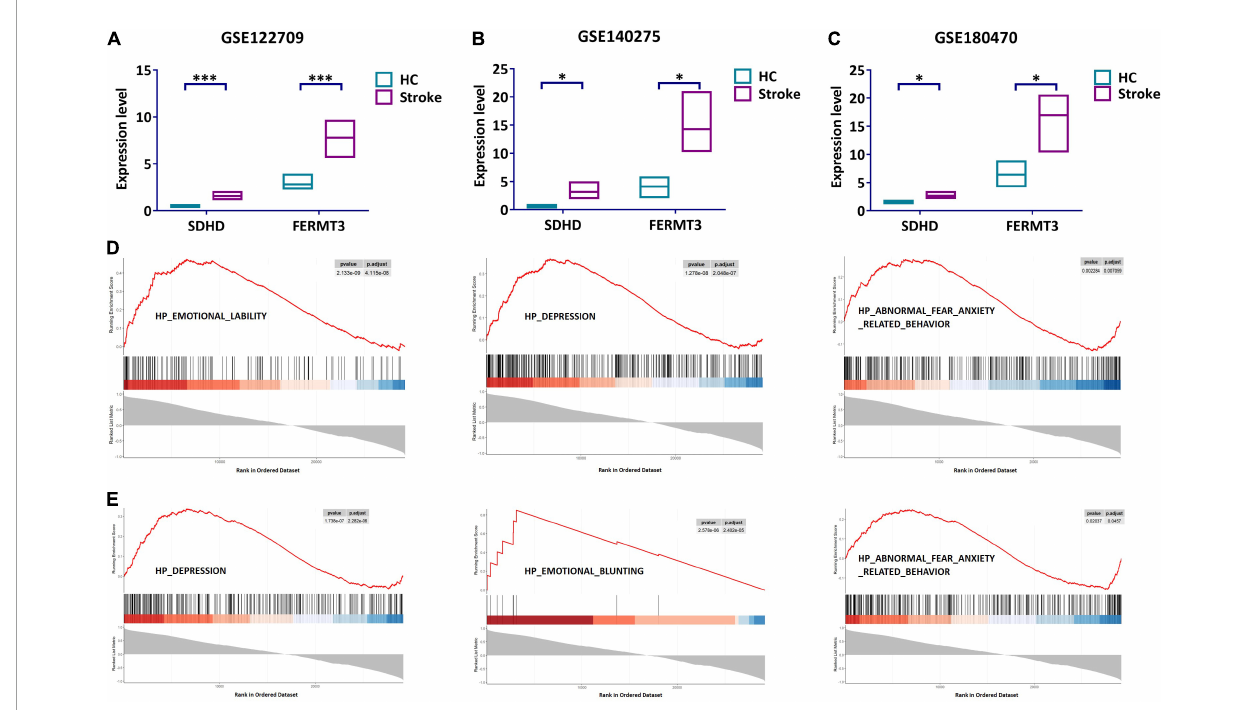
FIGURE6 Validation and GSEA analysis of signature genes. (A) Expression level of SDHD and FERMT3 in GSE122709. (B) Expression level of SDHD and FERMT3 in GSE140275. (C) Expression level of SDHD and FERMT3 in GSE180470. (D) GSEA analysis of SDHD. (E) GSEA analysis of FERMT3. ∗ P < 0.05; ∗∗∗ P < 0.001. HC, healthy control; GSEA, gene set enrichment